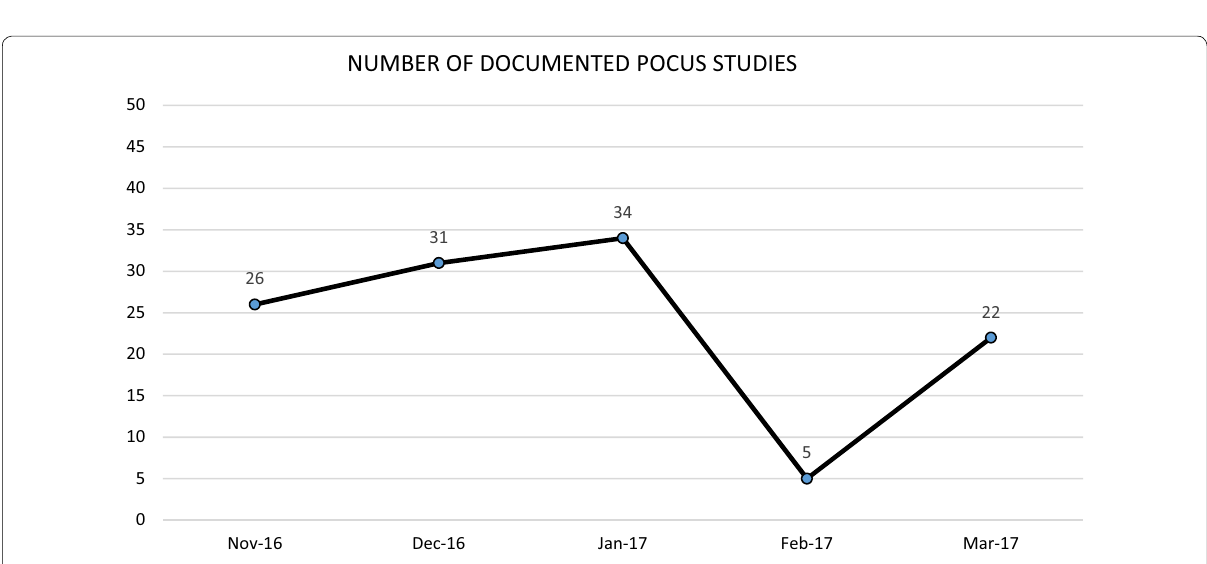
Fig. 2 Linear representation of the total number of documented POCUS studies over the 5 months following the study